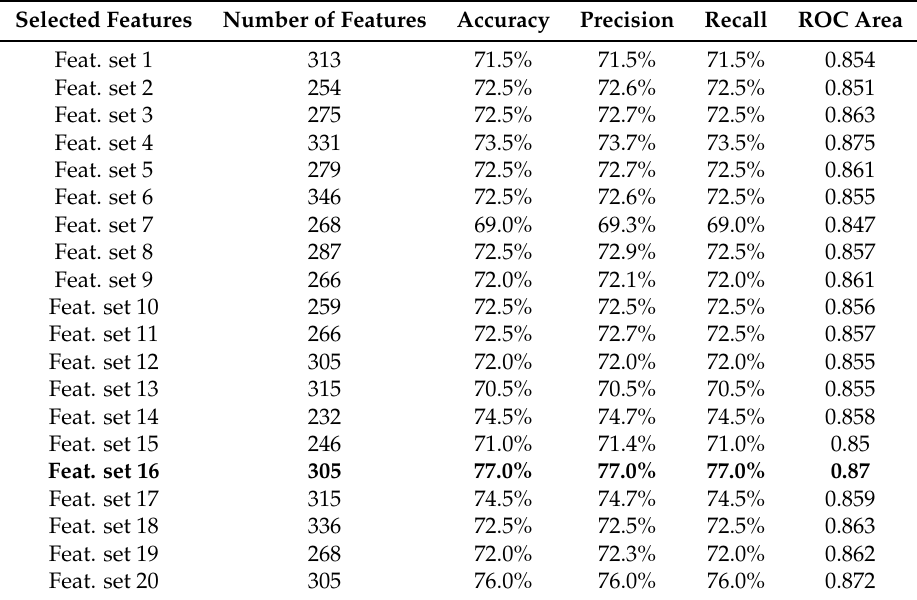
Table 6. Detection of benign or malignant using BGWO with curvelet features.